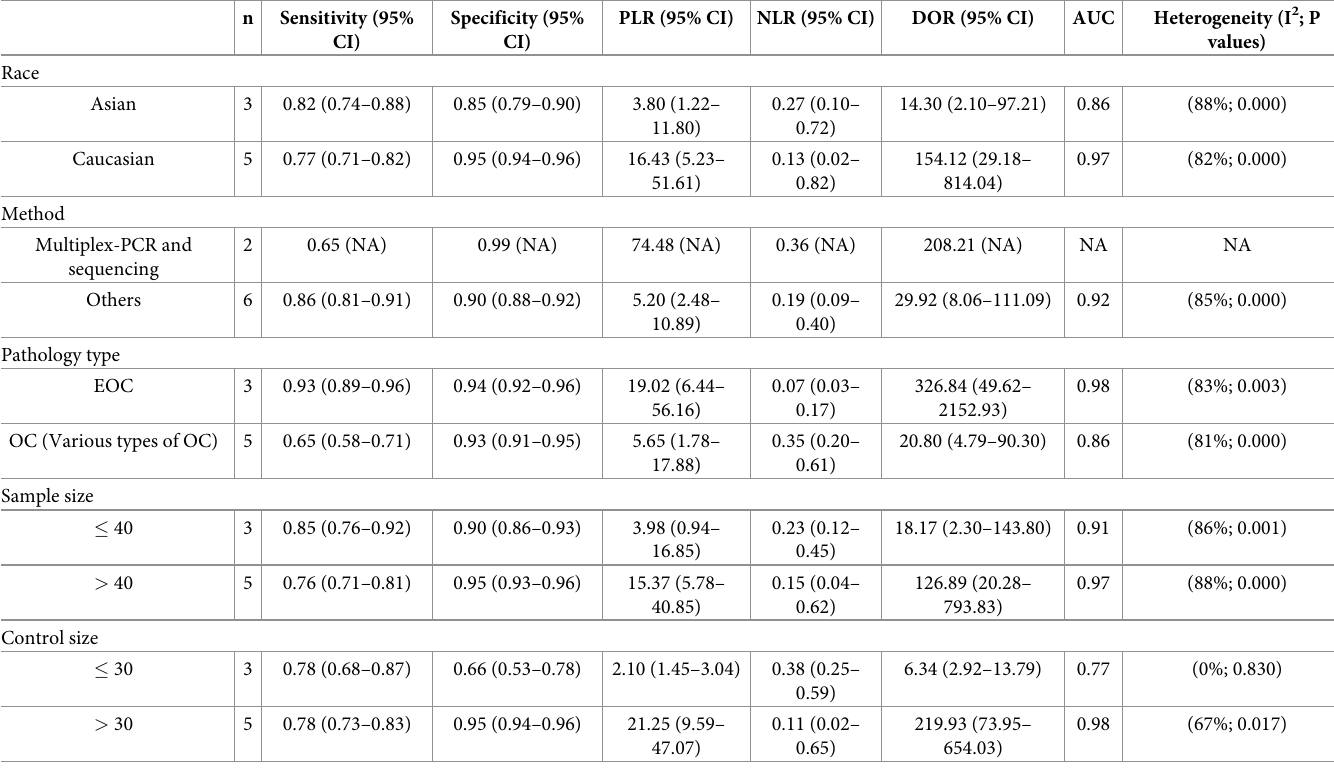
Table 3. Subgroup analysis of the diagnostic efficacy of ctDNA in